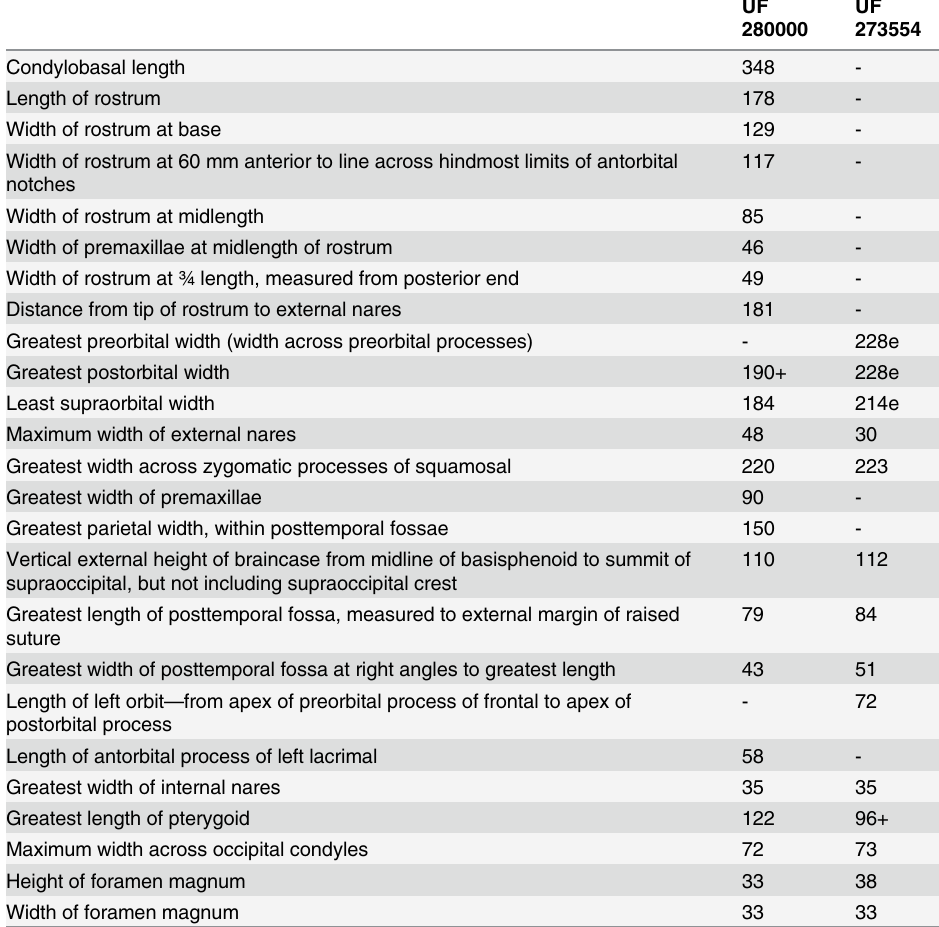
Table 1. Measurements (in mm) of skulls of Nanokogia isthmia gen. et sp. nov. (modified from Perrin [18]).